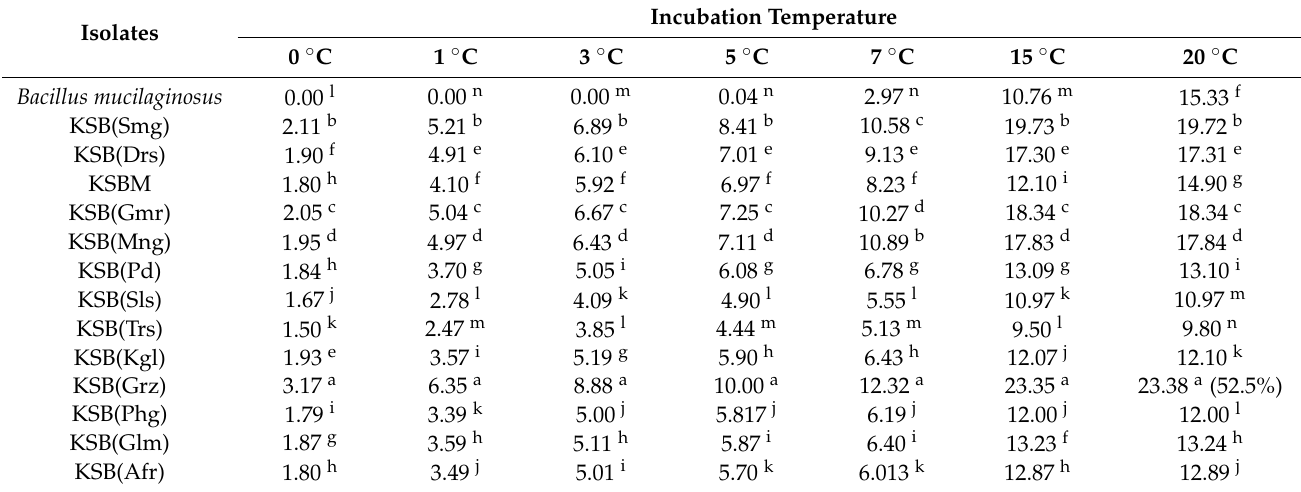
Table 4. Quantitative K solubilization ( µ g K/mL broth) potential of cold-tolerant bacterial isolates at different temperatures after 20 days of